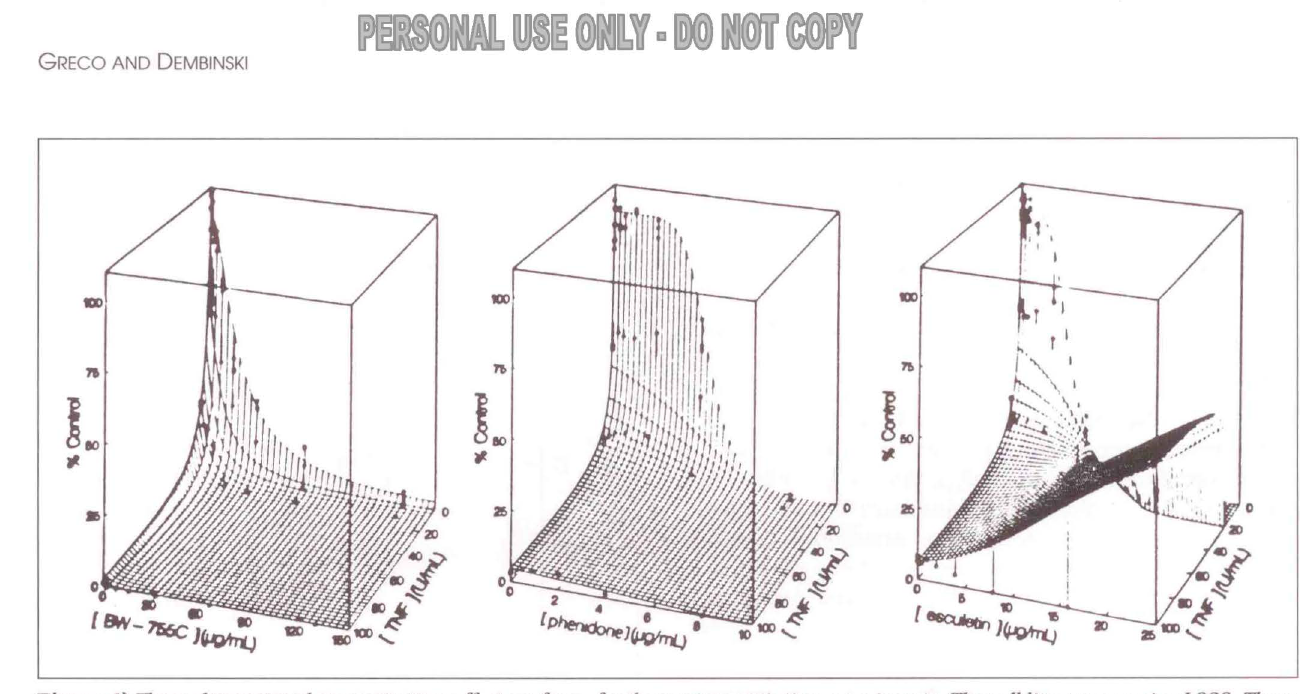
Figure 4) Three-dimensional concentration-effect surfaces for three representative experiments. The cell line was murine L929. The x and y-axes are drug concentrations on a linear scale. The z-axis (% control) is the effect (observed or predicted) divided by the best estimate of Emax. The combination of TNF plus BW-755C, schedule E, shows synergism; TNF plus phenidone, schedule A, shows additivity; and TNF plus esculetin, schedule B, shows antagonism. Fishnet surface, predicted concentration-effect surface. estimated .fromfitting Equation 1 to the data with nonlinear regression as described in the text; Points, measured response .from the absorbance from dyed cells in single culture wells. Solid points are above the surface open points fall below the surface. Vertical lines are .from